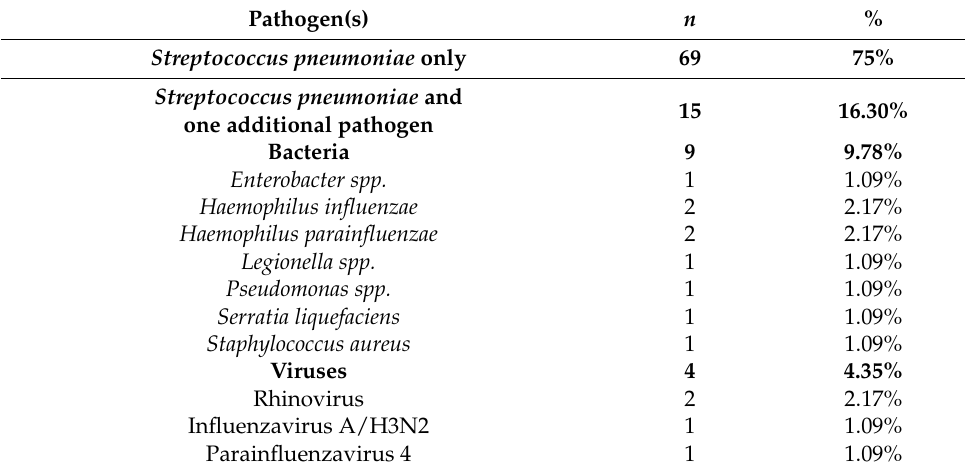
Table 2. List of pathogens detected in the CAPNETZ